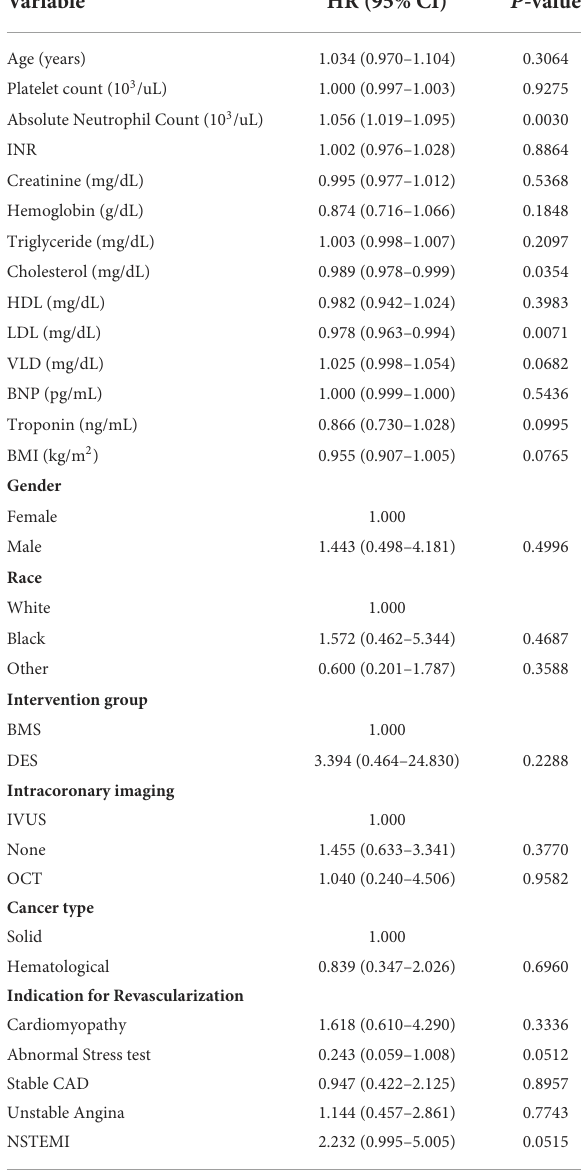
TABLE 6 Cardiovascular specific survival: Univariate Fine-Gray models, considering cardiovascular specific death as an event of interest and death as a competing risk event.